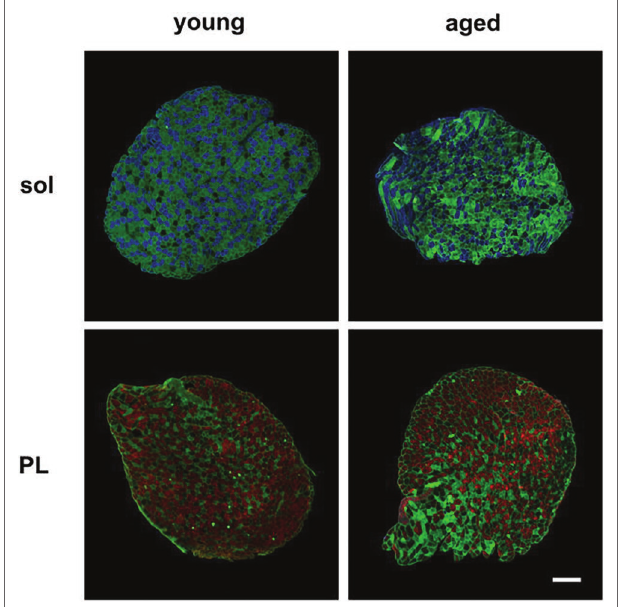
FIGURE 2 | Representative images of muscle-fiber typing of soleus and plantaris muscles. Muscle sections were stained with antibodies directed against myosin heavy chains. Indirect immunofluorescent staining of type I (blue), type IIb (red), type IIa (green), and type IId/x (no staining) fibers is shown in the soleus (sol) and plantaris (PL) muscles of the young and aged mice. Scale bar: 200